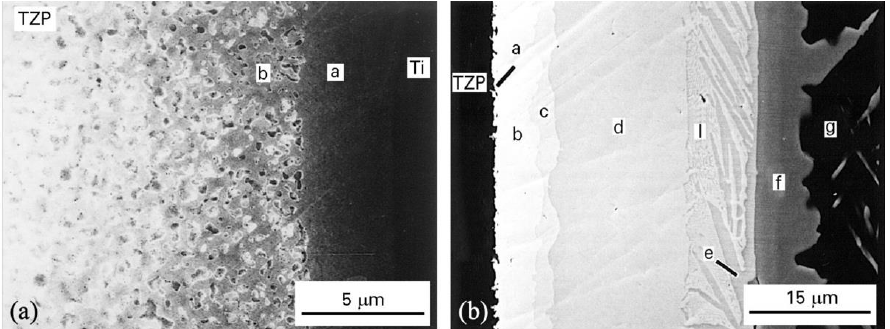
Figure 20. SEM images of: ( a ) ZrO 2 /Ti joint produced at 1494 °C for 180 min; ( b ) ZrO 2 /Pt/Ti6Al4V joint produced at 1328 °C for 15 min, reproduced from Reference [47] with permission of Springer,